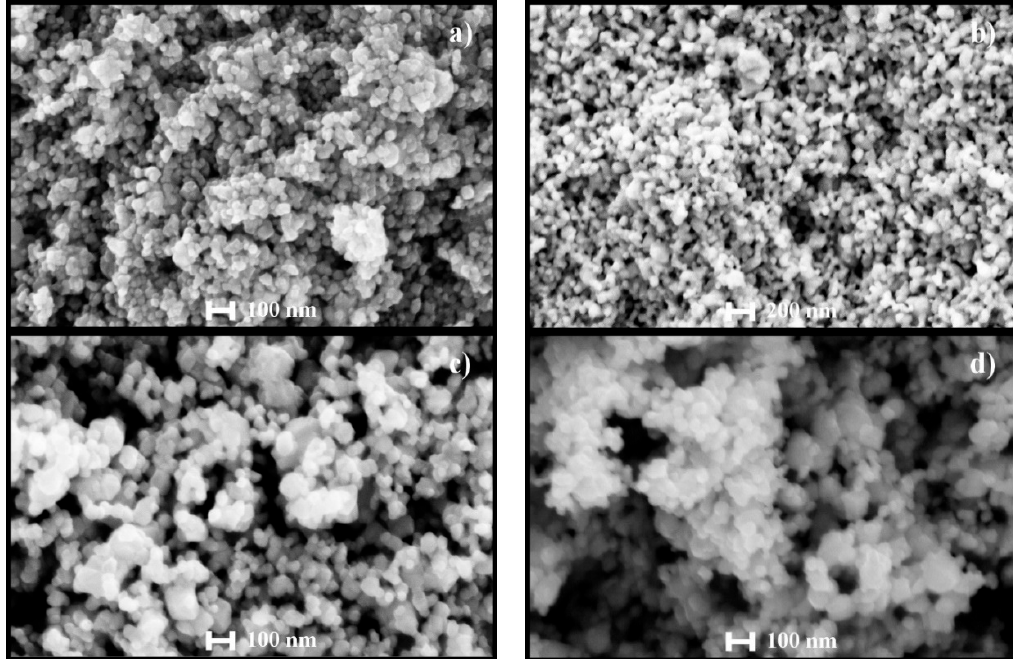
Figure 3. SEM images of pure SnO 2 powders ( a ) before and ( b ) after ball milling; and Cu-incorporated SnO 2 powders ( c ) before and ( d ) after ball milling, respectively.